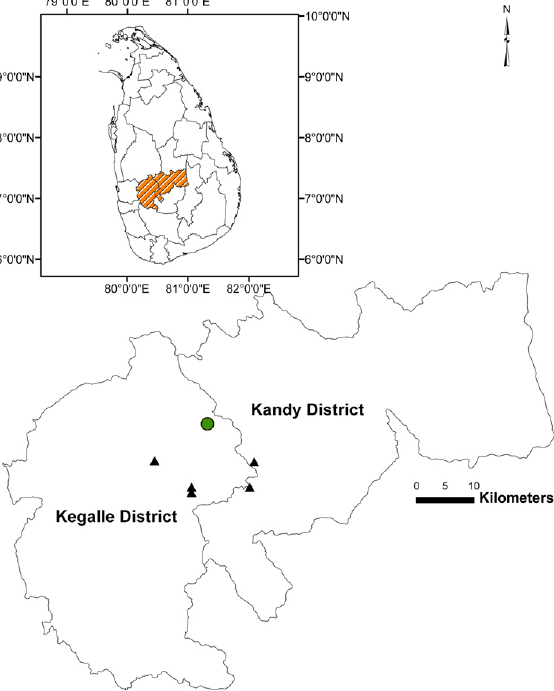
Figure 1. Present Distribution of Ceylonthelphusa armata . Circle indicates the type locality.